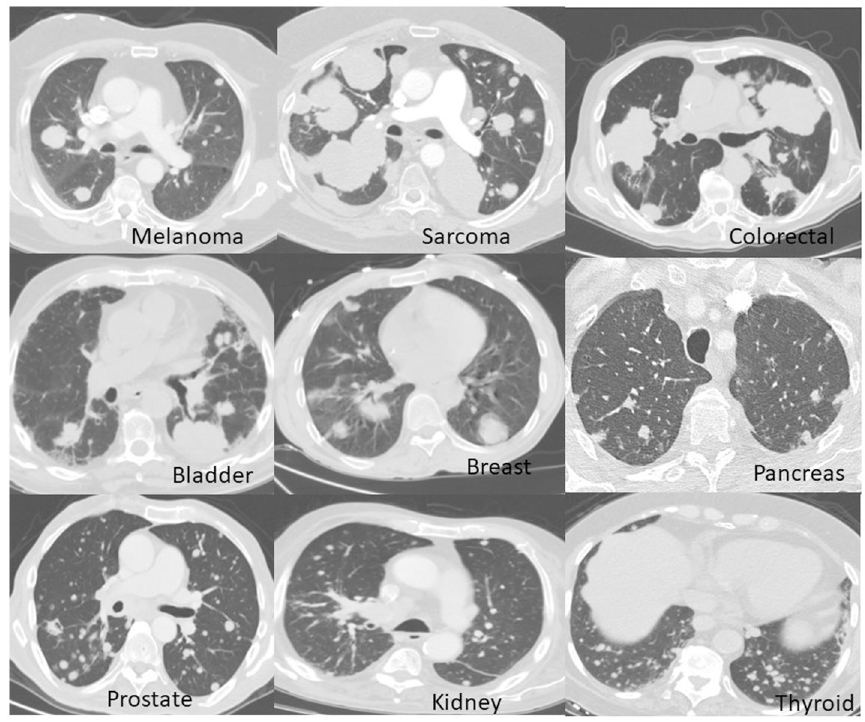
Fig 2. Representative chest CT scans of patients with lung metastases. Patients with melanomas, sarcomas, colorectal, bladder and breast cancers typically show variable diameters of metastases, while patients with pancreas, prostate, kidney, and thyroid cancers typically show metastases of similar